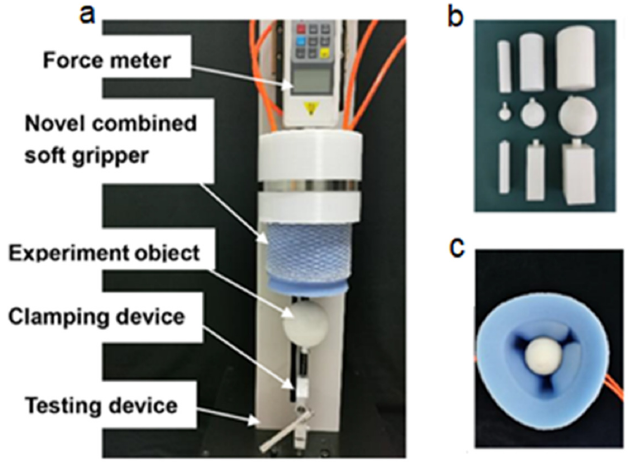
Figure 7. ( a ) Load capacity testing device. ( b ) Experimental objects for grasping and holding ex- periment. ( c ) The state of grasping an experimental object using the cylindrical soft actuator.